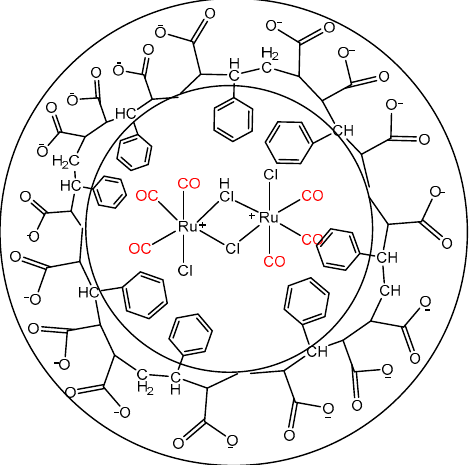
Figure 7. Tricarbonylchlororuthenium (II) dimer (CORM ‐ 2) synthesized with water ‐ soluble styrene ‐ maleic acid copolymer (SMA) for micellization CORMats.